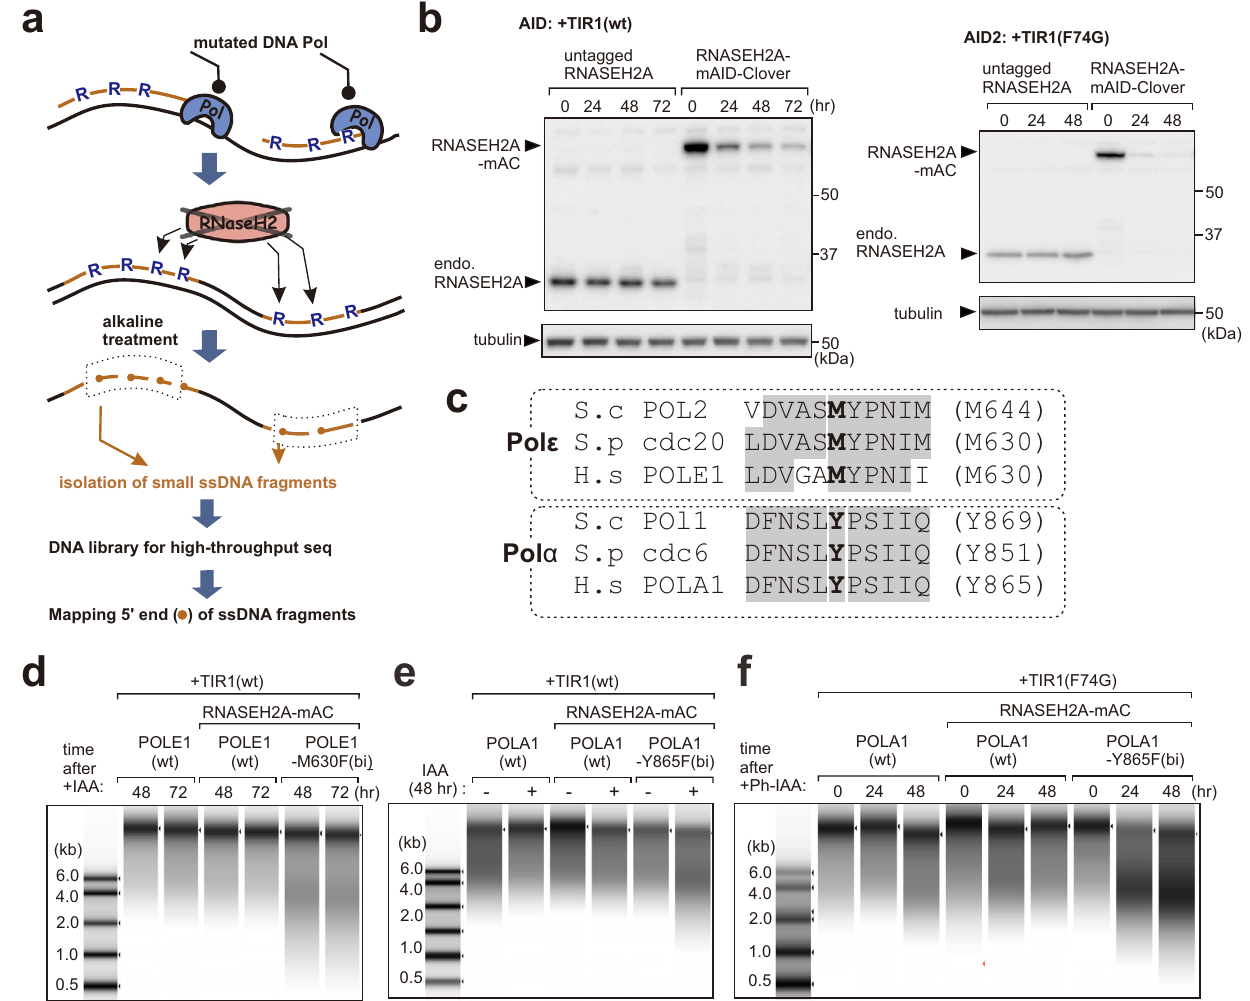
Fig. 1 | Ribonucleotide incorporation into DNA in POLE1-M630F and POLA1- Y865F cells. a Schematic representation of Pu-seq. Top: ribonucleotides (R) are incorporatedbythemutatedDNApolymerase.OchrelinesindicatethepartofDNA synthesis by the mutated polymerase. Middle: in the absence of RNase H2- dependent RER, rNMPs remain in the DNA. Bottom: the sugar backbone of DNA strand is cleaved at sites of rNMP incorporation by alkali. Small ssDNA fragments (dashedbox)are collected and subjectedto librarypreparation and sequencing to identifythe 5 ʹ end of ssDNAfragment(circled end ofochrelines)asthe location of rNMP. b Left: auxin-induced degradation of RNASEH2A following addition of indole-3-acetic acid (IAA) to cells expressing wild type O. sativa TIR1 (AID system).